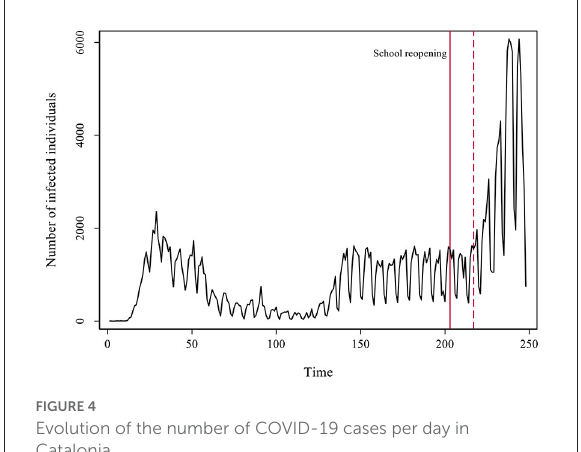
FIGURE4 Evolution of the number of COVID-19 cases per day in